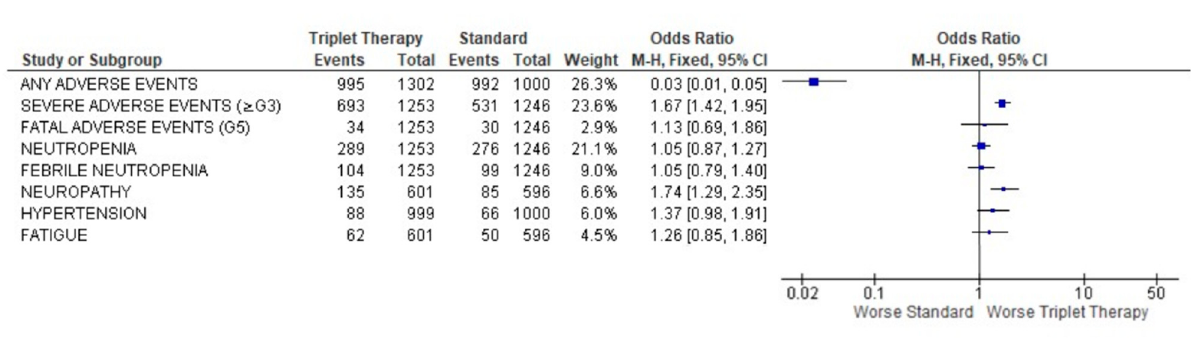
Figure 4. Forest plot of ( a ) overall survival hazard ratios in low volume patients, ( b ) overall survival hazard ratios in high-volume patients, and ( c ) overall survival hazard ratios in de novo patients included in the meta-analysis, obtained using a random model. Studies are arranged by publication year.